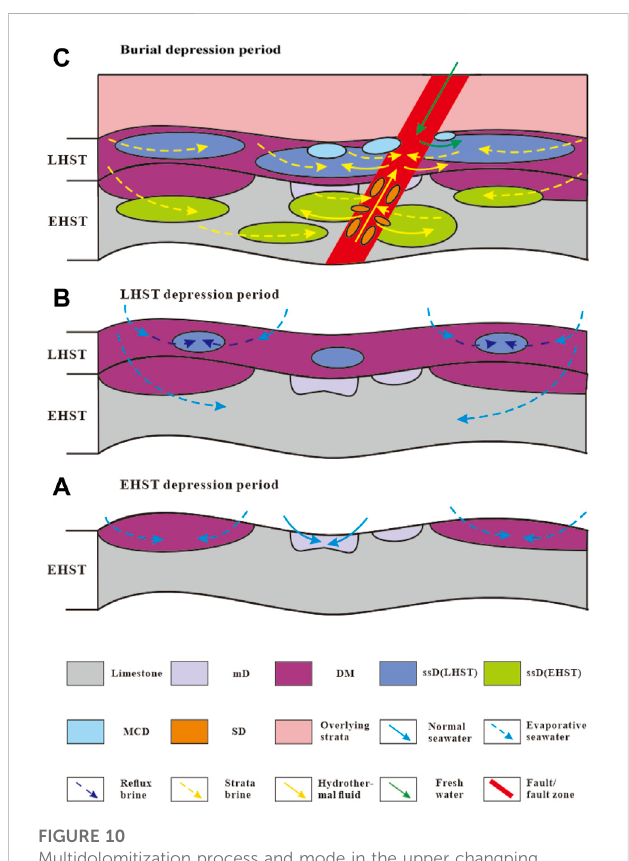
FIGURE 10 Multidolomitization process and mode in the upper changping